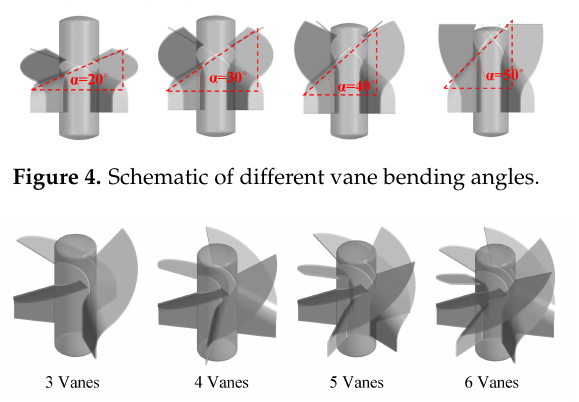
Figure 5. Schematic of different swirl vane quantities.